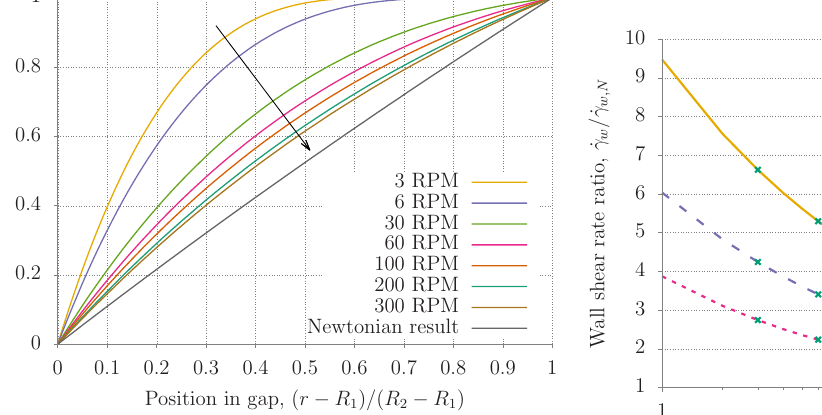
τ y = 5 . 0 Pa τ y = 2 . 5 Pa